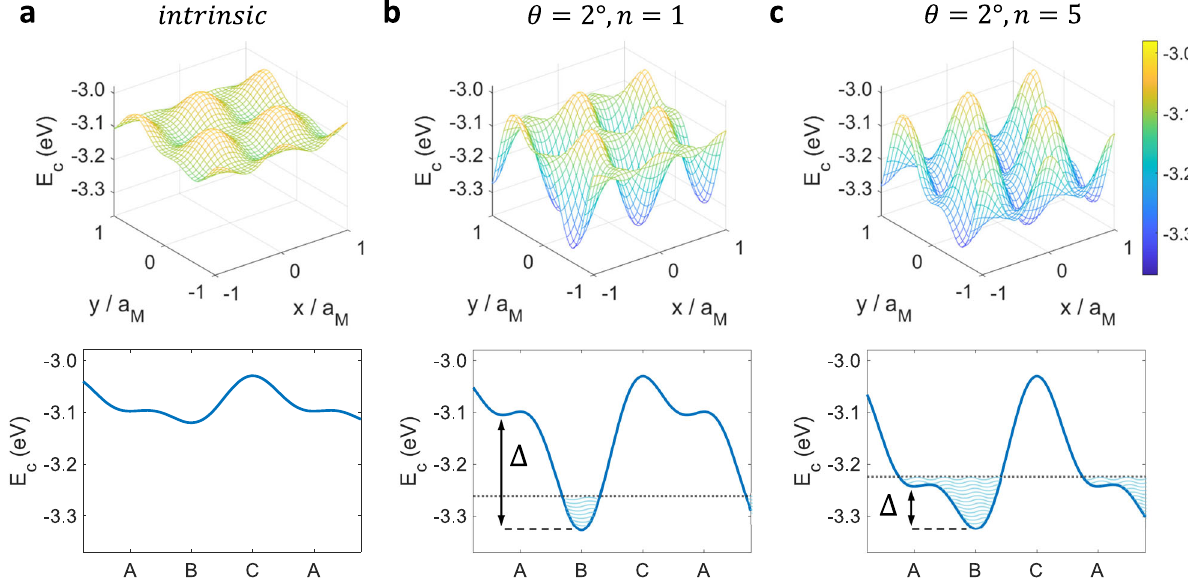
Fig. 2 Moiré potential renormalization under carrier doping. Real-space moiré potential of the 2° twisted MoS 2 /WS 2 a intrinsic structure, b doped with n = 1 electron per moiré superlattice, c doped with n = 5 electrons per moiré superlattice. The charge-transfer gap Δ is labeled in ( b , c